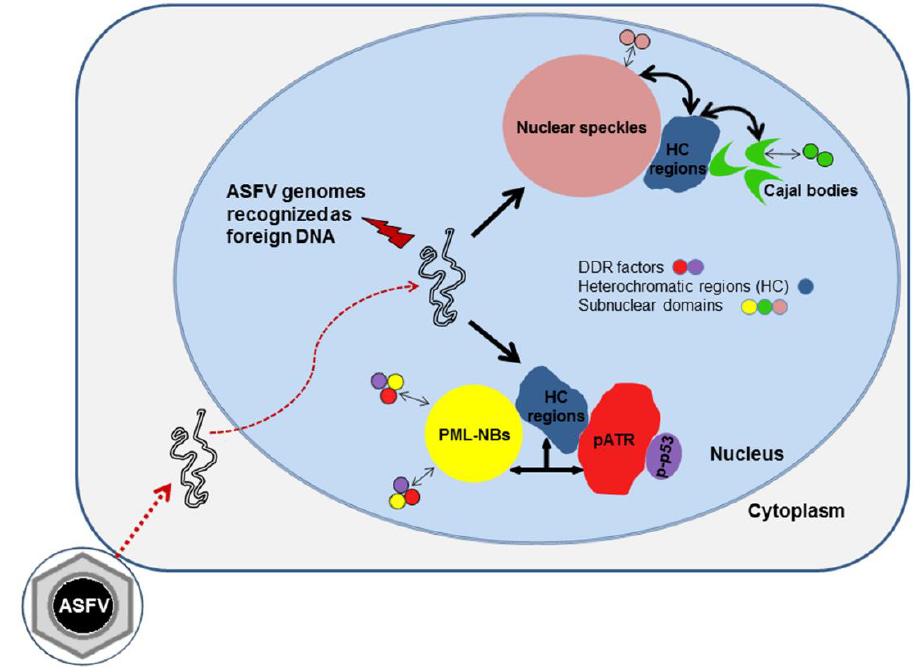
Figure 6. Proposed working model for ASFV-host interactions. ASFV-infected cells show a fully reorganized nuclear architecture. ASFV genomes most probably recognized as DNA damage sites, after migrating into host cell nucleus, activate DNA damage response factors (p-p53 and pATR), that juxtapose to enlarged PML-NBs (yellow circles). The activated p53 (p-p53, purple circles) and ATR (pATR, red shapes) also accumulate nearby heterochromatic regions (blue forms). In addition, the viral infection promotes nuclear speckles enlargement (pink circles) and Cajal bodies remodelling (green “comma-shaped” forms). All subnuclear domains display close vicinity to viral-induced heterochromatic regions enriched by H3K9me3, H3K27me3, HP1 α / β isoforms and